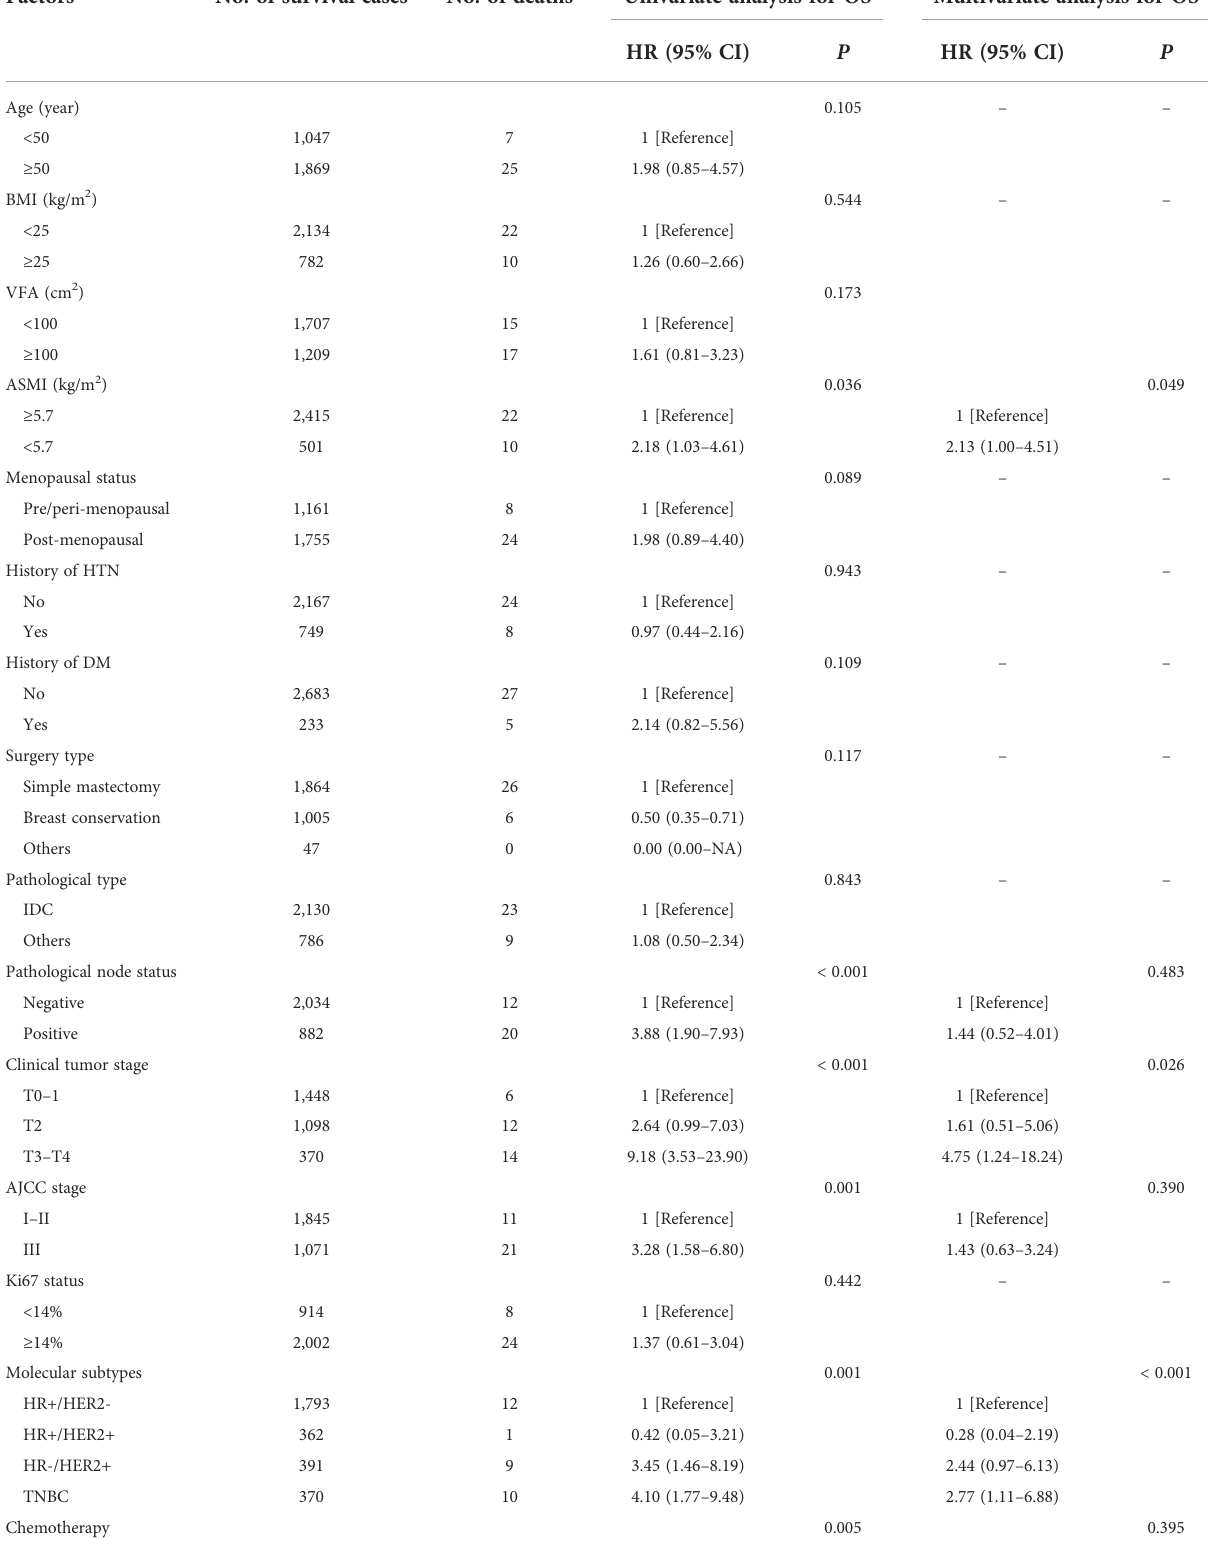
TABLE 3 Univariate and multivariate analysis of factors associated with OS.